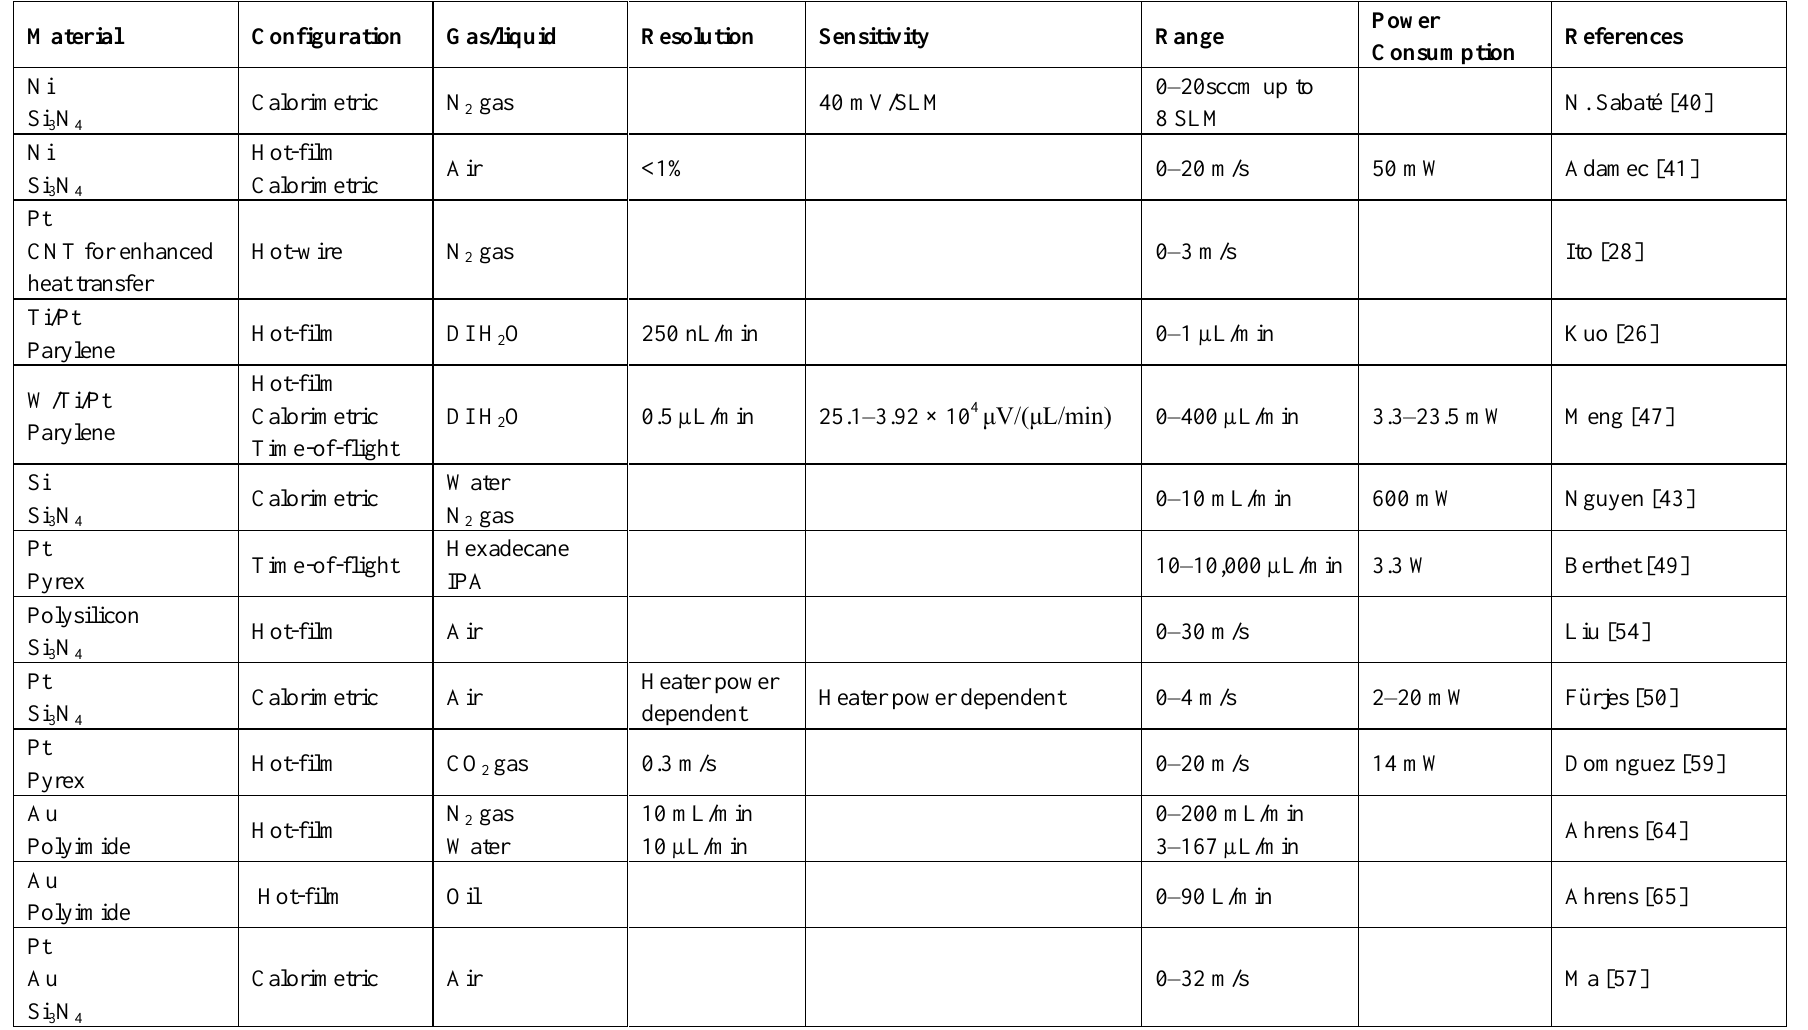
Table 3. Thermoresistive flow sensor feature